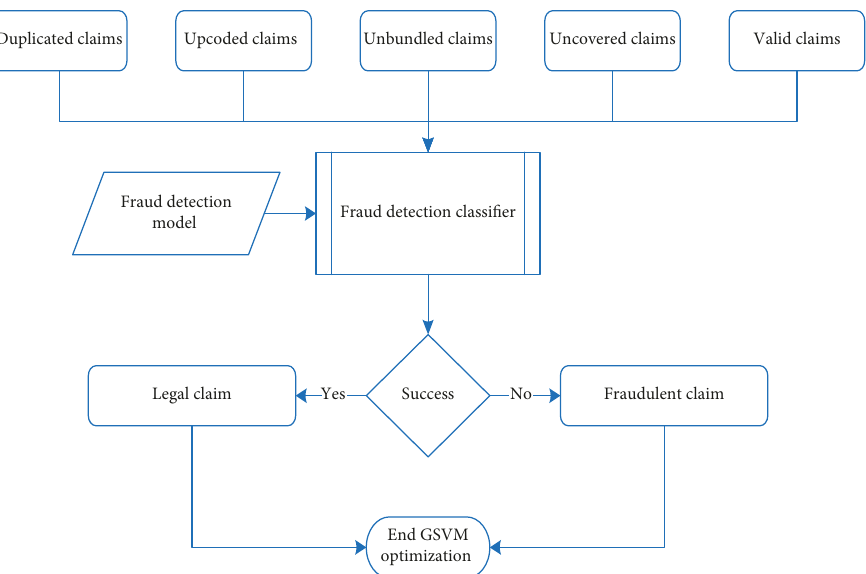
Figure 4: Conceptual model design and development of the genetic support vector